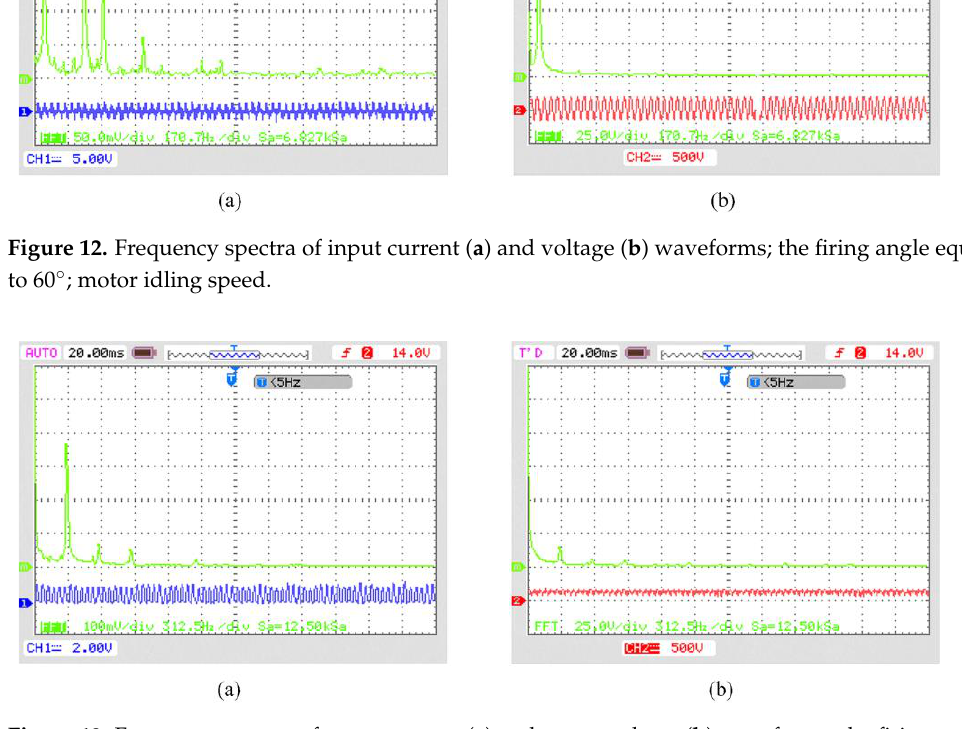
Figure 13. Frequency spectra of motor current ( a ) and motor voltage ( b ) waveforms; the firing angle equal to 60°; motor idling speed.